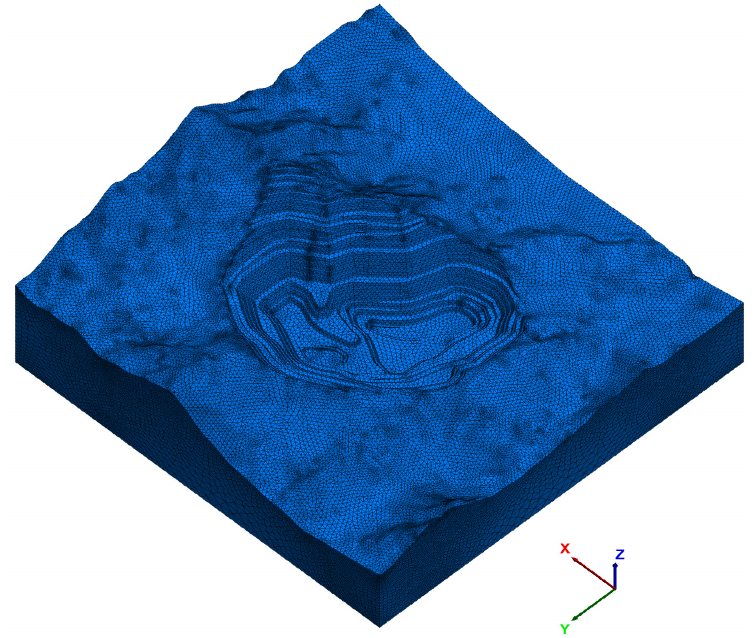
Figure 5. Three-dimensional model of the final realm of open-pit Figure 5. Three ‐ dimensional model of the final realm of open ‐ pit mining.